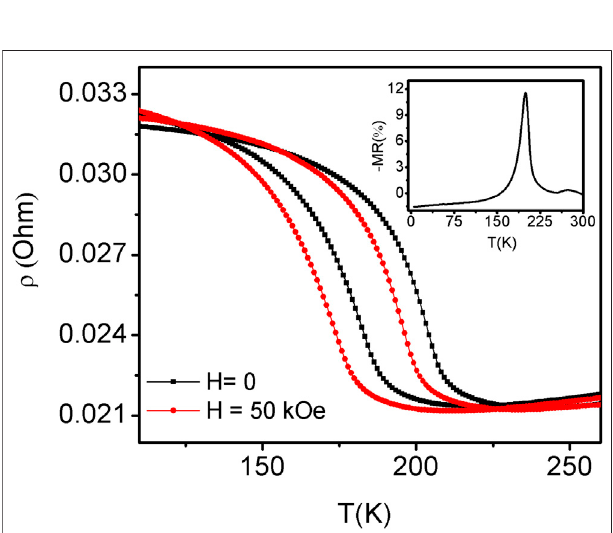
FIGURE9 | Temperature asa function ofresistivity ( ρ ),measured in zero and 50 kOe fi eld. Inset shows the magnetoresistance (MR) as a function of temperature, calculated from these ρ -T